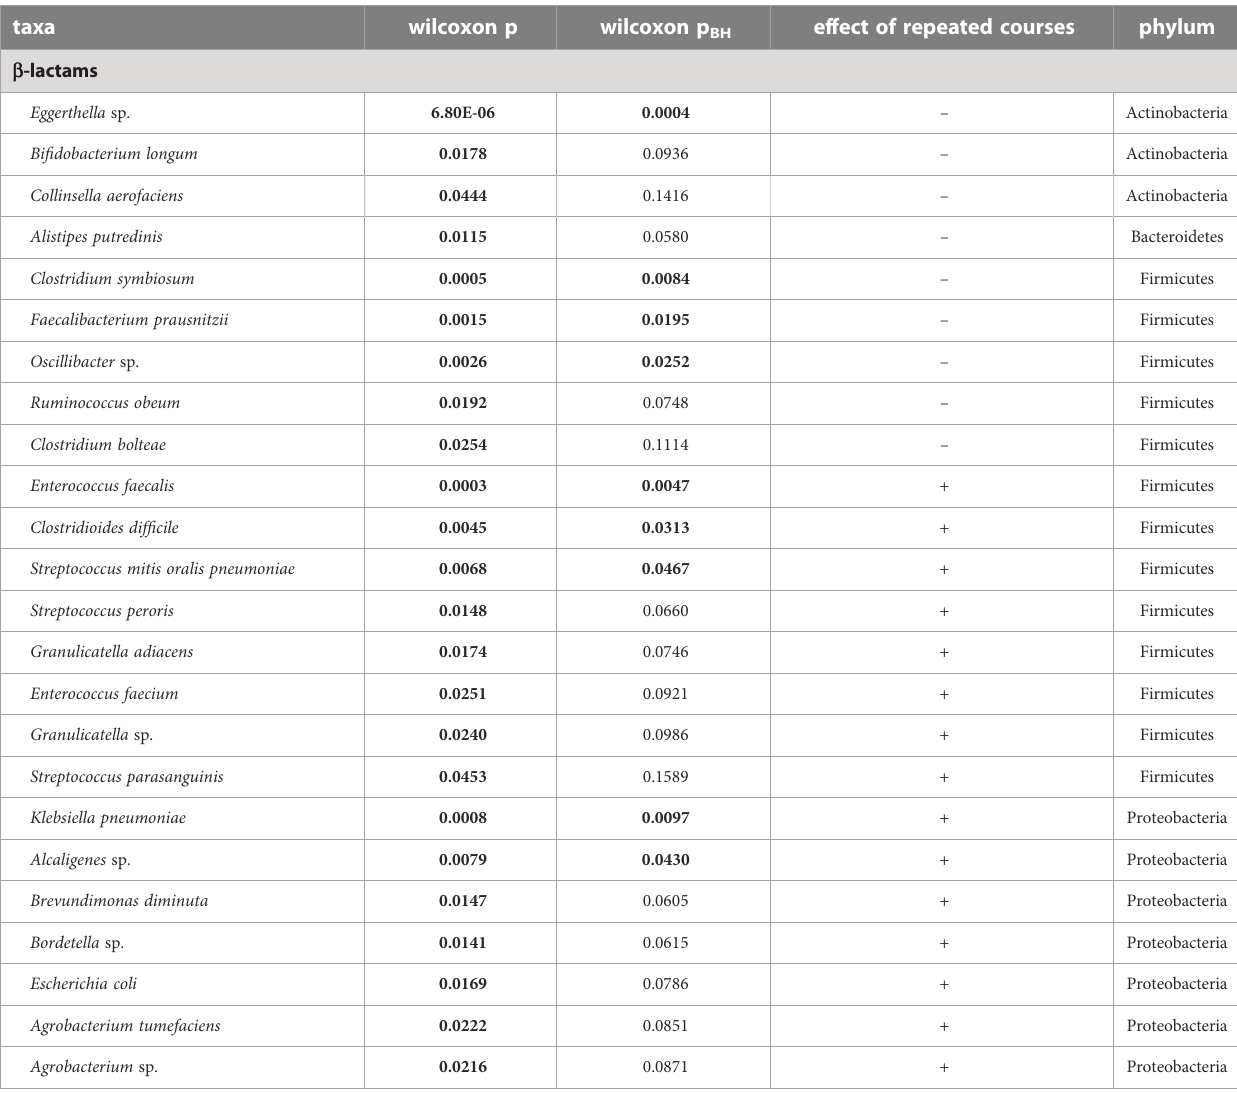
TABLE 2 Taxa identi fi ed in differential abundance analysis (ALDEx2) as differing signi fi cantly with repeated courses (1-2 vs 3+ courses) of b -lactam, vancomycin or AAb.